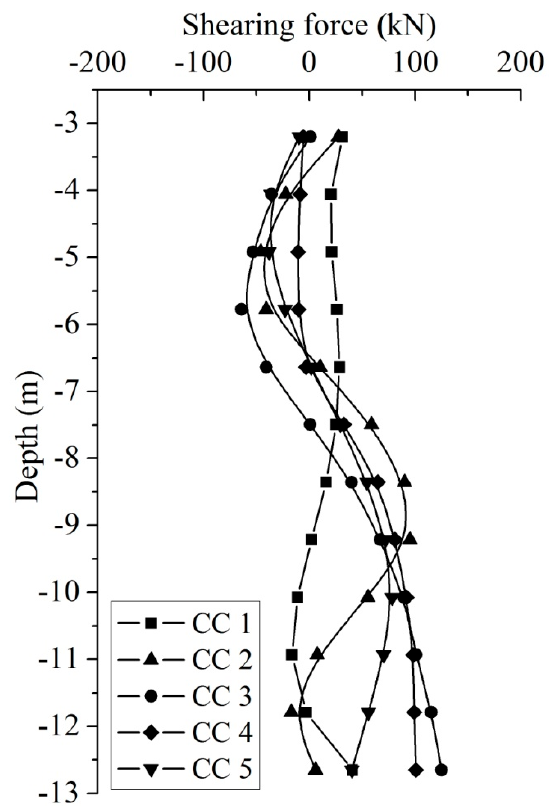
Figure 6. The shearing force distribution curves of the H-shaped steel in the SMW pile Z1 under five construction conditions (construction condition is abbreviated